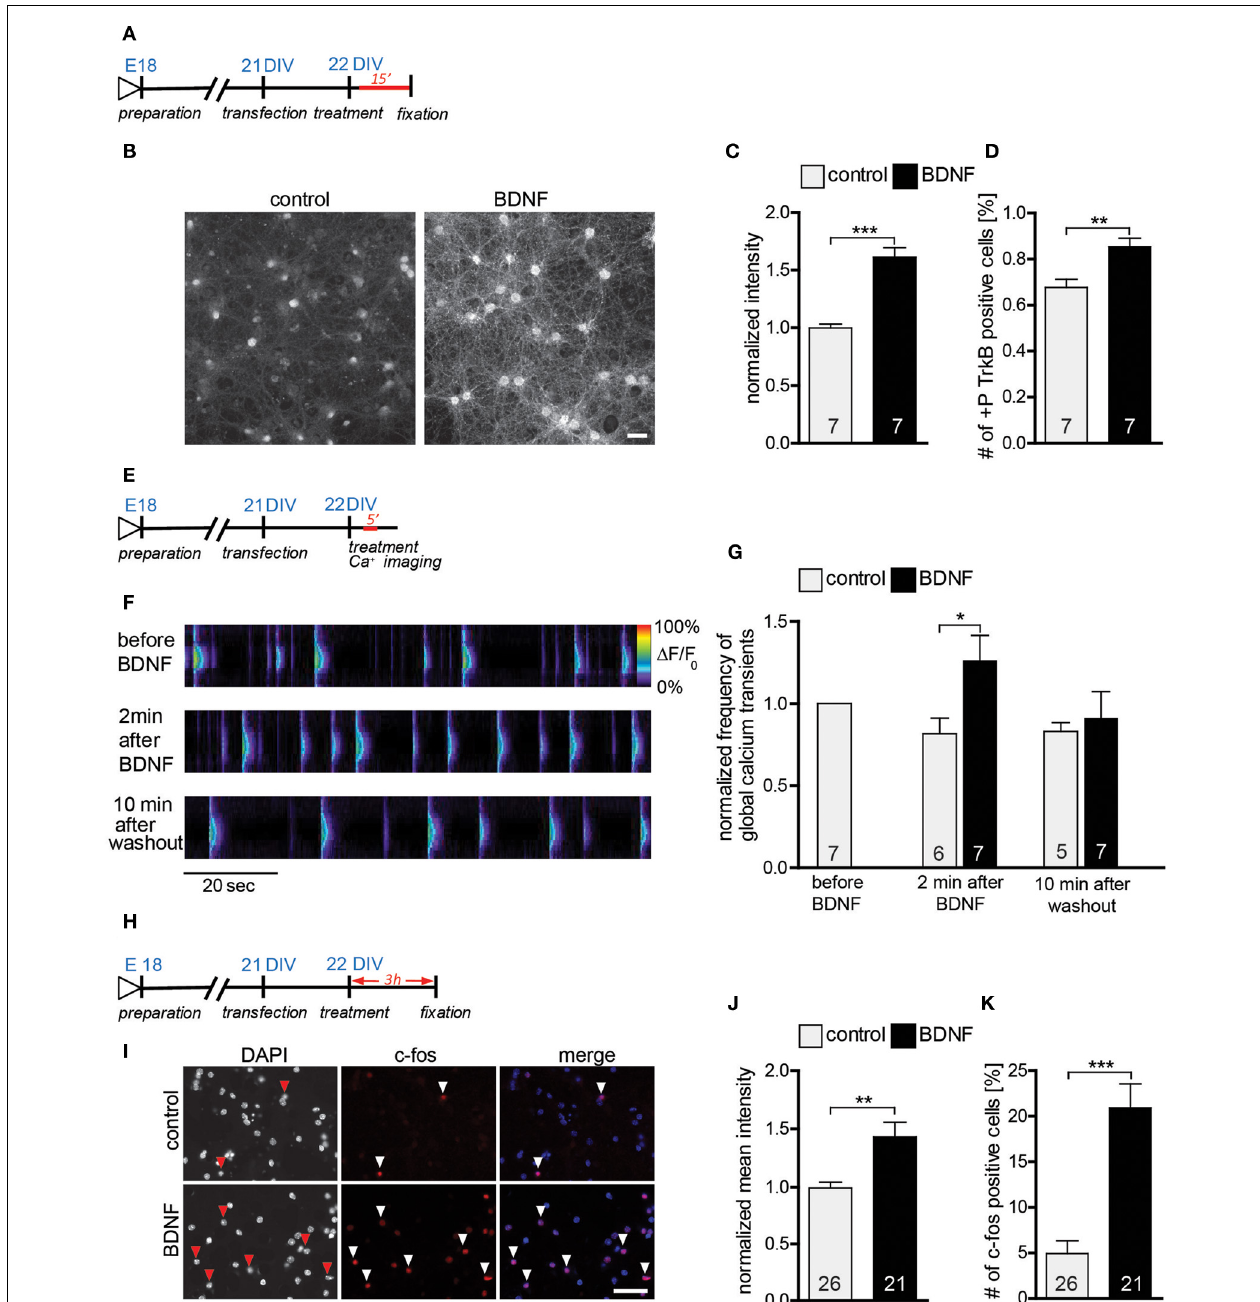
FIGURE 4 | (A) Experimental timeline. DIV22 primary hippocampal neurons were treated 15min with BDNF before fixation. (B) Images of primary hippocampal cultures (22DIV) treated with either BSA (control) (left) or BDNF (right) and stained with an anti-phospho-TrkB receptor antibodies. Scale bar, 40 μ m. (C) Histogram showing the normalized fluorescence intensity for the phospho-TrkB receptor under control conditions or treated with BDNF. (D) Graph showing the number of phospho-TrkB positive hippocampal neurons in control and BDNF treated hippocampal primary cultures. (E) Experimental timeline. DIV22 primary hippocampal neurons were treated 5min with BDNF during calcium imaging. (F) Pseudo line-scan showing the global calcium transients occurring in hippocampal primary cultures before, during and after BDNF applications. (G) Graph showing